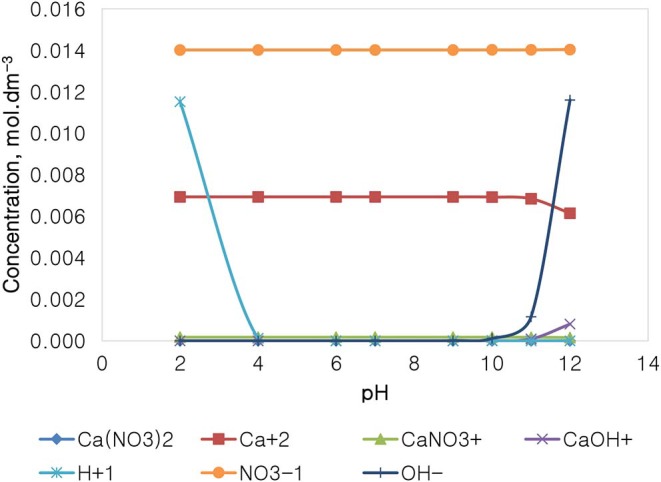
Ca(NO3)2 speciation for a solution of 0.0213 mol dm−3 ionic strength.